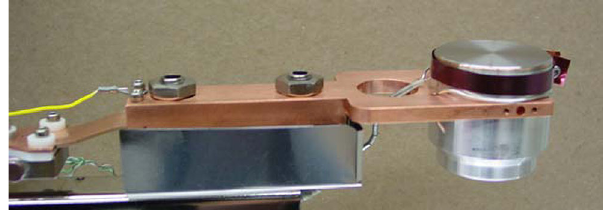
FIG. 1. The transfer arm of the BNL K 2 CsSb deposition system holding the stainless steel and aluminum puck. The puck can be biased for QE measurements, heated, and